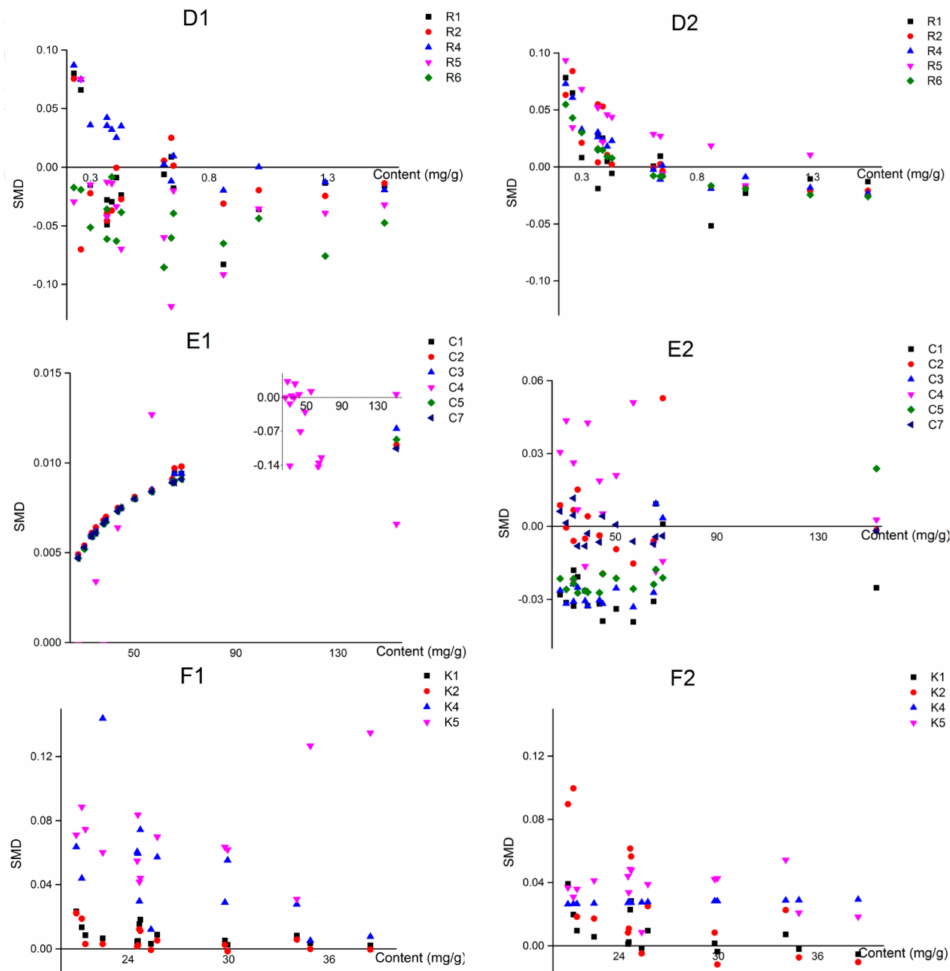
Figure 5. The scatter diagrams reflecting the standard method differences (SMDs) of fifteen analytes in 15 batches of Ilex kudingcha C. J. Tseng assayed by using LRG-QAMS ( D1 ~ F1 )/AVG-QAMS ( D2 ~ F2 ) method and the content of the internal referring substances (X axis represents the content of internal referring substances of R4, C6 and K3 in D, E and F scattered gram,